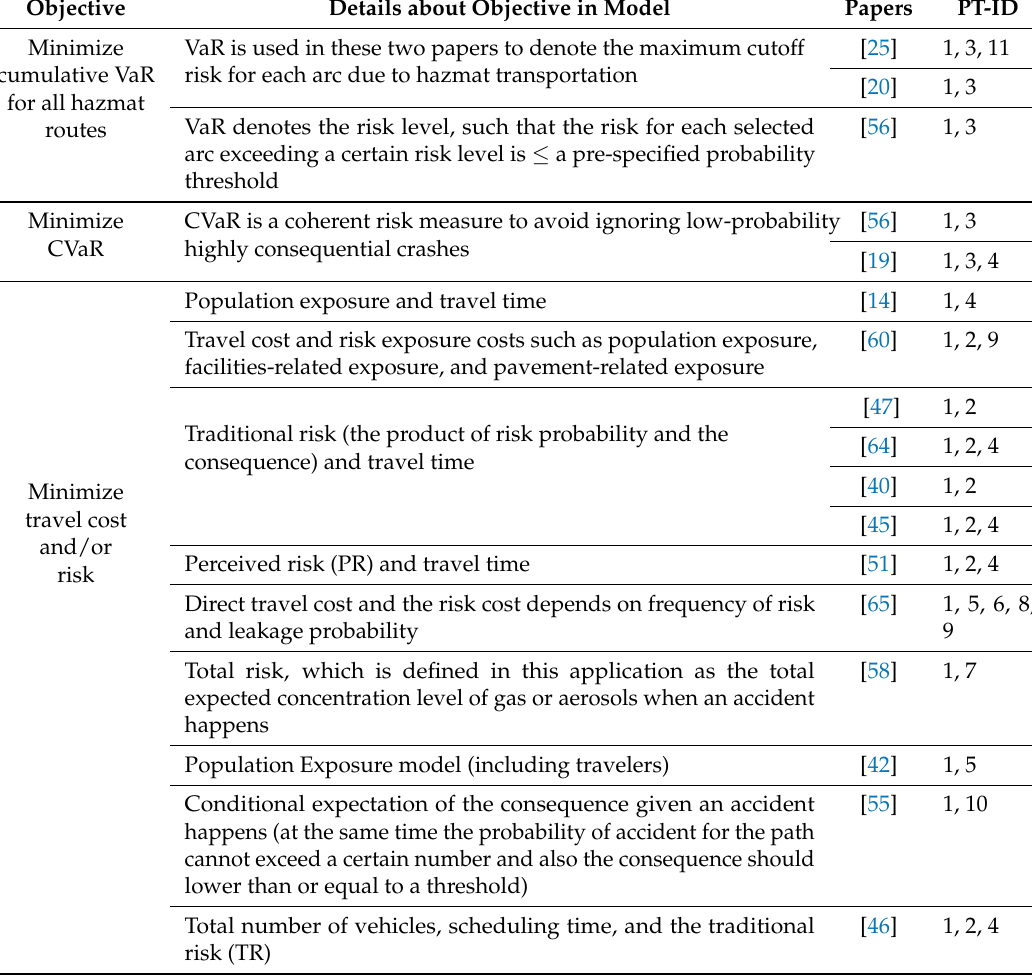
Table 4. Details about objective function(s) and parameter type ID (PT-ID) used in the literature. Objective Details about Objective in Model